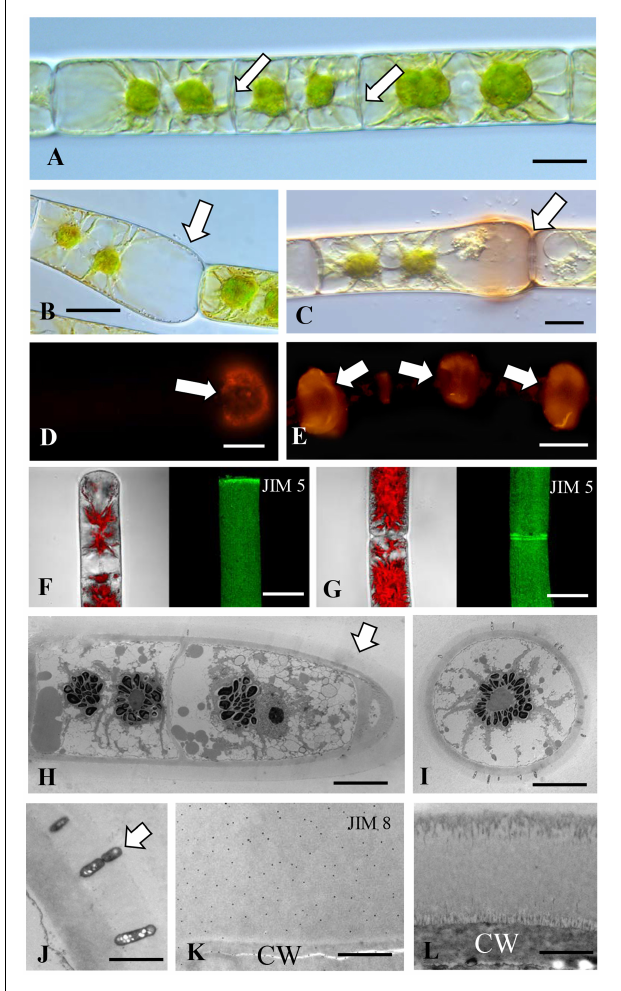
FIGURE 4 | Zygnema : (A) Cross walls of the unbranched filament (arrows). Bar7 µ m. (B) Cell wall (arrow) at swelling of cell at a fragmentation site (arrow). Bar 12 µ m. (C) ß-glucosyl-Yariv labels the wall and sheath of the swollen zone (arrow). Bar 12 µ m. (D) JIM13 labeling of ECM at the swollen fragmentation zone (arrow). Bar 15 µ m. (E) JIM13 labeling of “clouds” of ECM at the cross walls of filaments (arrows). Bar 15 µ m. (F) JIM5 labeling (right) of terminal cell and corresponding bright field image with chloroplast autofluoescence (left). (G) JIM5 labeling of two connected cells, notice the two rings in the connection zone (arrow). Bars ( F , G ) 20 µ m. (H) TEM image of young filament with broad electron translucent ECM layer surrounding the cells (arrow). (I) Cross section through filament. Bars ( H , I ) 20 µ m. (J) Bacteria in the ECM layer of a young filament (arrow). (K) JIM8 immuno-gold labeling of the ECM layer outside the cell wall (CW). (L) ECM of older cell, notice the fibrillary structures outside the CW and at the periphery. Bars ( J – L ) 2 µ m.